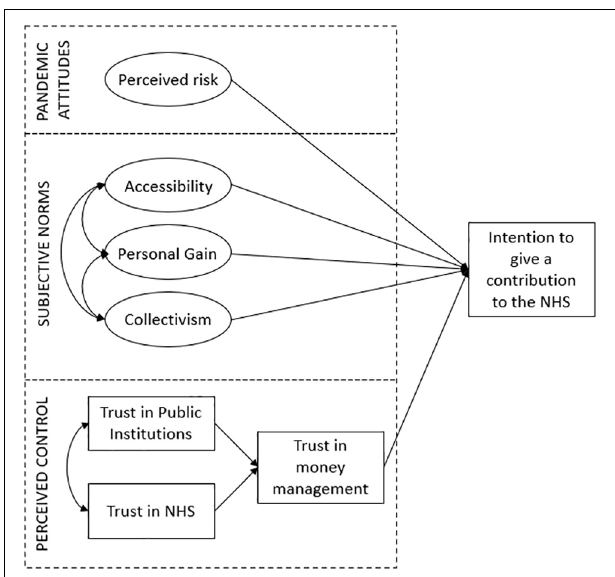
FIGURE 1 | Model of antecedents of the intention to make a financial contribution to the